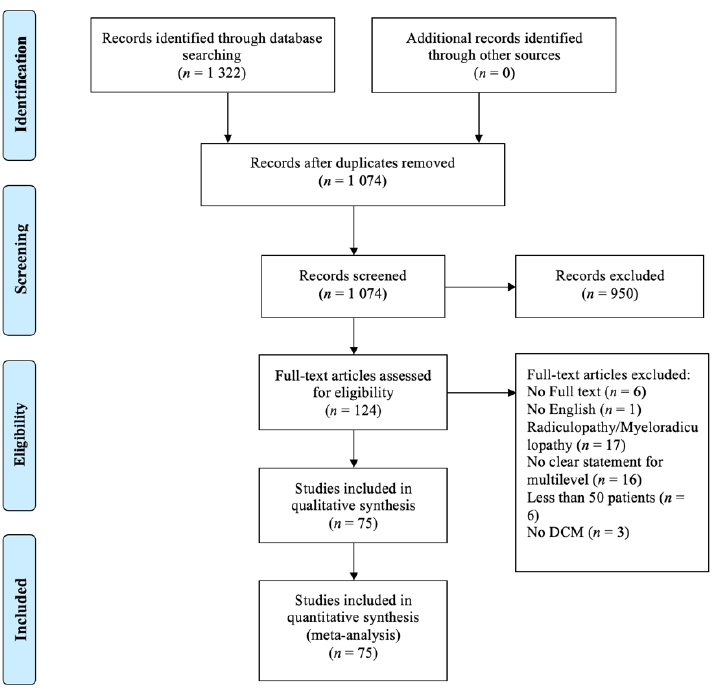
Figure 1. PRISMA flow diagram of search strategy.